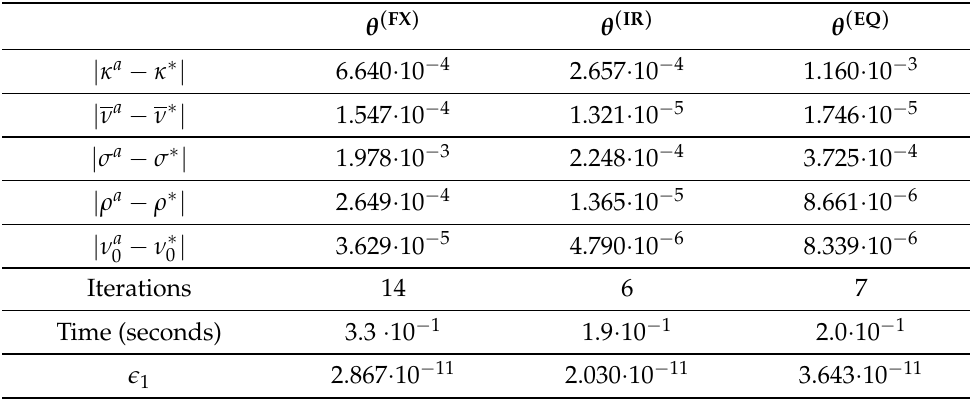
Table 5. Convergence statistics averaged over 100 calibrations. x a refers to the calibration problem’s estimation of variable x a . For example, | κ a − κ ∗ | refers to how close LM approximation of κ was to the real